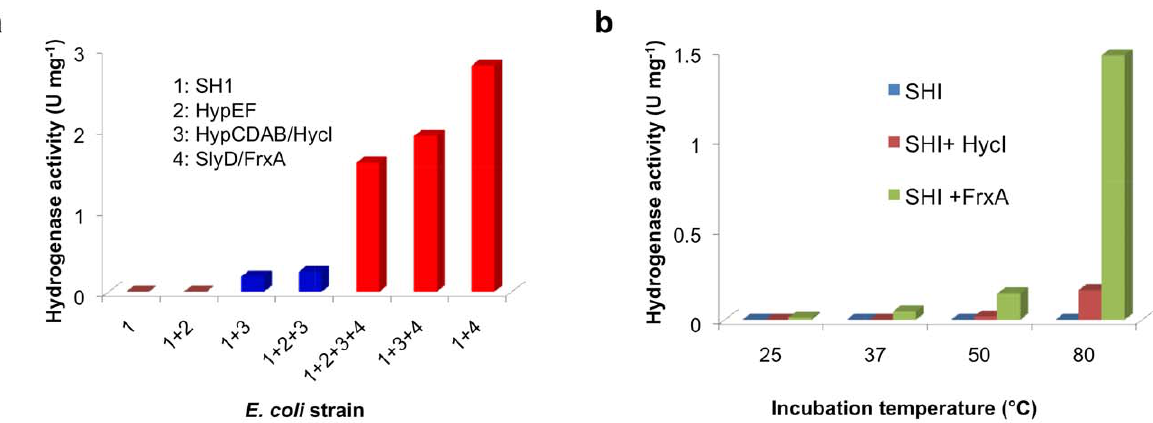
Figure 4. Accessory proteins required for maturation of recombinant P.furiosus SHI invivo and invitro . ( a ) Recombinant SHI (rSHI) was expressed in the presence of different Pf processing genes and the resulting E. coli cell-extracts were assayed at 80 u C. The bars indicate methyl viologen-linked specific activity expressed as U mg 2 1 or m mol H 2 evolved min 2 1 mg 2 1 . FrxA but not SlyD is necessary to produce high amounts of active hydrogenase. ( b ) Processing of rSHI in cell-free extracts of E. coli by FrxA and HycI of P. furiosus . An E. coli cell-extract containing rSHI (PF0891- 0894) as the only expressed Pf genes, was added to another cell-extract containing only either FrxA or HycI as the only expressed Pf genes. The mixtures were incubated for 30 min at the indicated temperature and the specific activity was determined at 80 u C by the methyl viologen-linked assay.